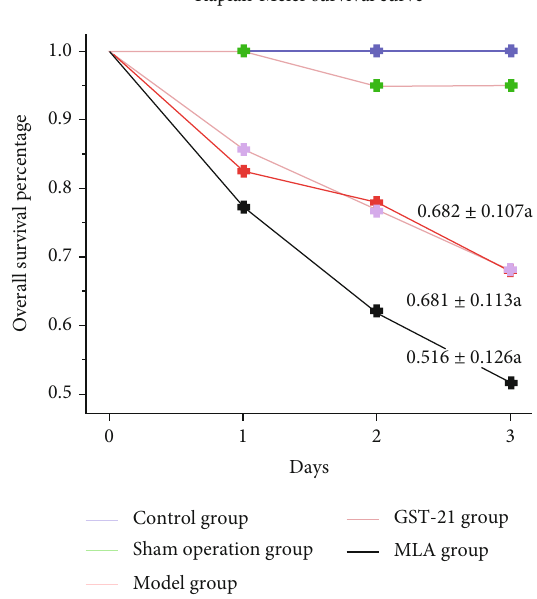
Figure 1: Kaplan-Meier survival curve among the fi ve groups. On the fi rst postoperative day, the model group, GTS-21 group, and MLA group had more deaths than the control group. On the second and third days, the cumulative survival rates of the GTS-21 group were close to the model group, and the cumulative survival rate of the MLA group continued to decline. There was no statistical di ff erence in the cumulative survival rates of the three sepsis groups ( χ 2 = 1 : 21 , P > 0 : 05 ), but they were signi fi cantly lower than that of the control group and the sham group. Both the control group and the sham group had no death, and there were signi fi cant di ff erences between the fi ve groups ( χ 2 = 14 : 21 , P < 0 : 01 ). a: P < 0 : 05 vs. control group.